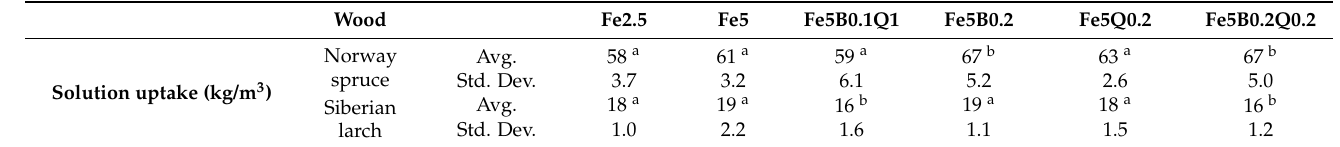
Table 3. Solution uptake in cylindrical samples used for outdoor